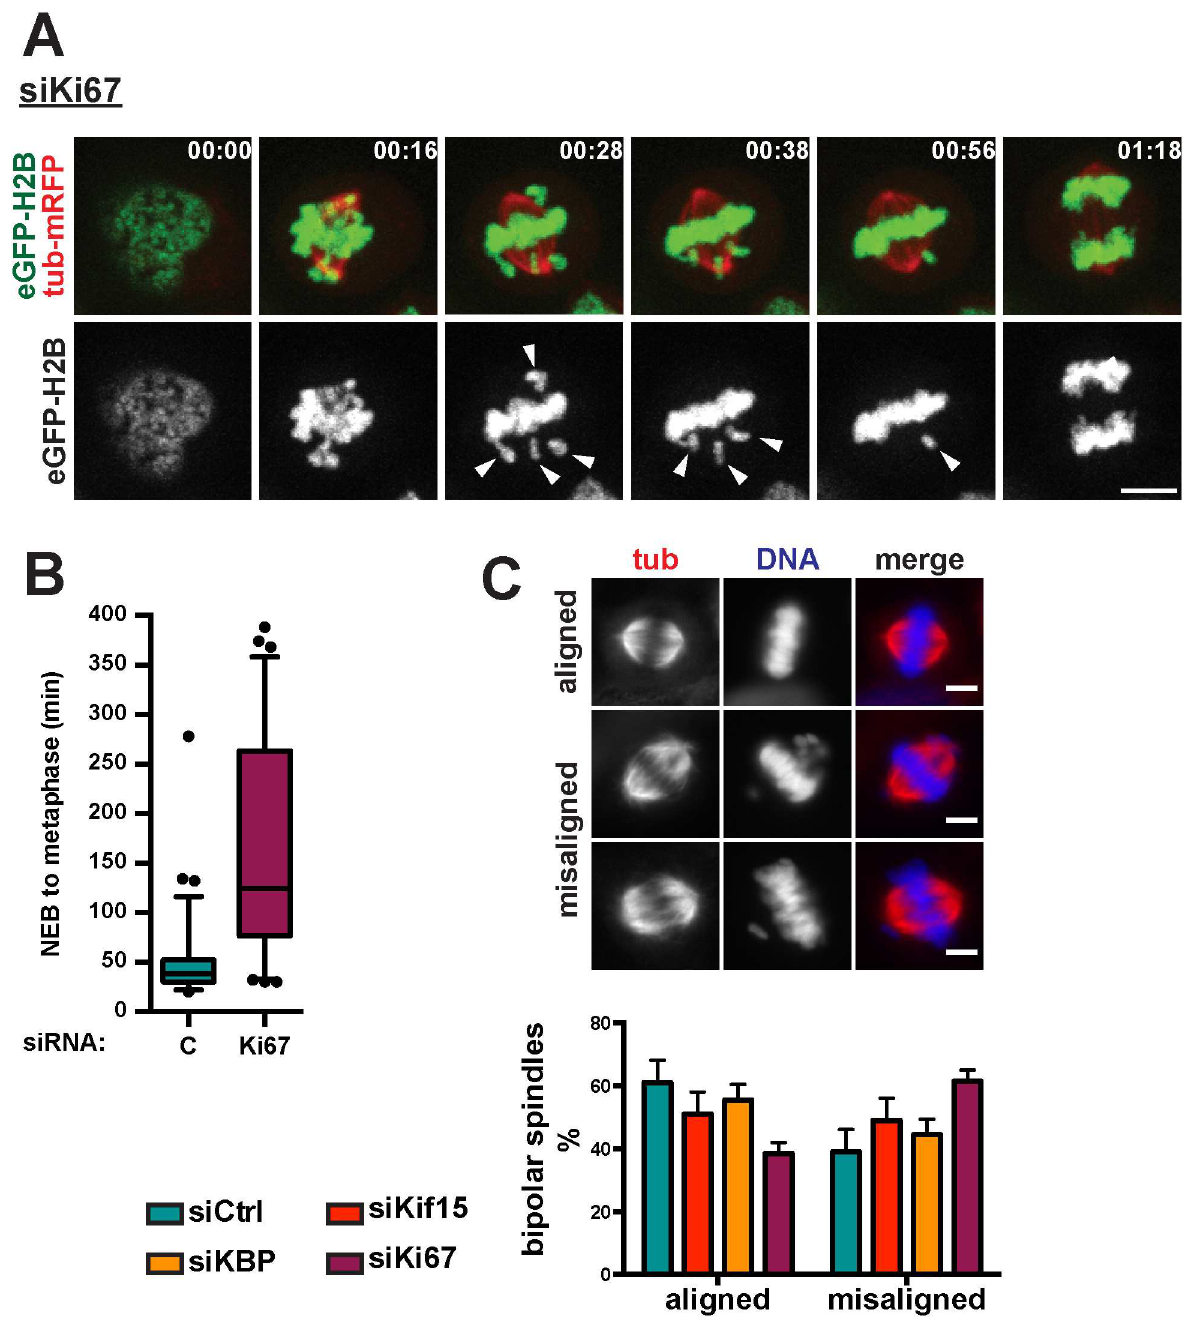
Fig 4. Chromosomally localized Kif15 is required for chromosome alignment. (A) Representative stills from the live-cellimagingof Ki67-silencedcells. Arrowheadsindicate chromosomes that show less efficient alignment to the metaphaseplate. Time is indicatedin the upper left corner as hh:mm. Scale bar represents5 μ m. (B) Quantificationof prometaphase durationas observedin the live-cell imagingin controlor Ki67-silenced cells. Prometaphase was definedas the time neededfor cellsto progressfrom NEBD till anaphase onset. Time points are represented in box-and-whisker plots. Boxes show the upper and lower quartiles(25–75%)with a line at the median, whiskersextendfrom the 5 th to the 95 th percentile. Dots representthe outliers(data were comparedusingMann-Whitney U tests, **** means p (cid:20) 0.0001). (C) Upperpanel: Representative immunofluorescenceimagesshowingbipolarspindles with fully alignedor misalignedchromosomes. Lowerpanel:Quantification of chromosome alignmentin control, KBP, Kif15 or Ki67-silenced cells (scale bar 5, μ m). Cells with bipolarspindles were categorized baseduponthe degreeof chromosome alignment, i.e. fully alignedchromosomes (metaphasecells), misaligned chromosomes (most chromosomes have congressed to the metaphaseplate, few chromosomes are not alignedyet). Graph shows the averageandstandarddeviationof three independent experiments with at least 61 cells countedper condition,per experiment (data were analyzedusing t tests, no significant differences were observed). https://doi.org/10.1371/journal.pone.0174819.g004 PLOS ONE | https://doi.org/10.1371/journal.pone.0174819 April 26,